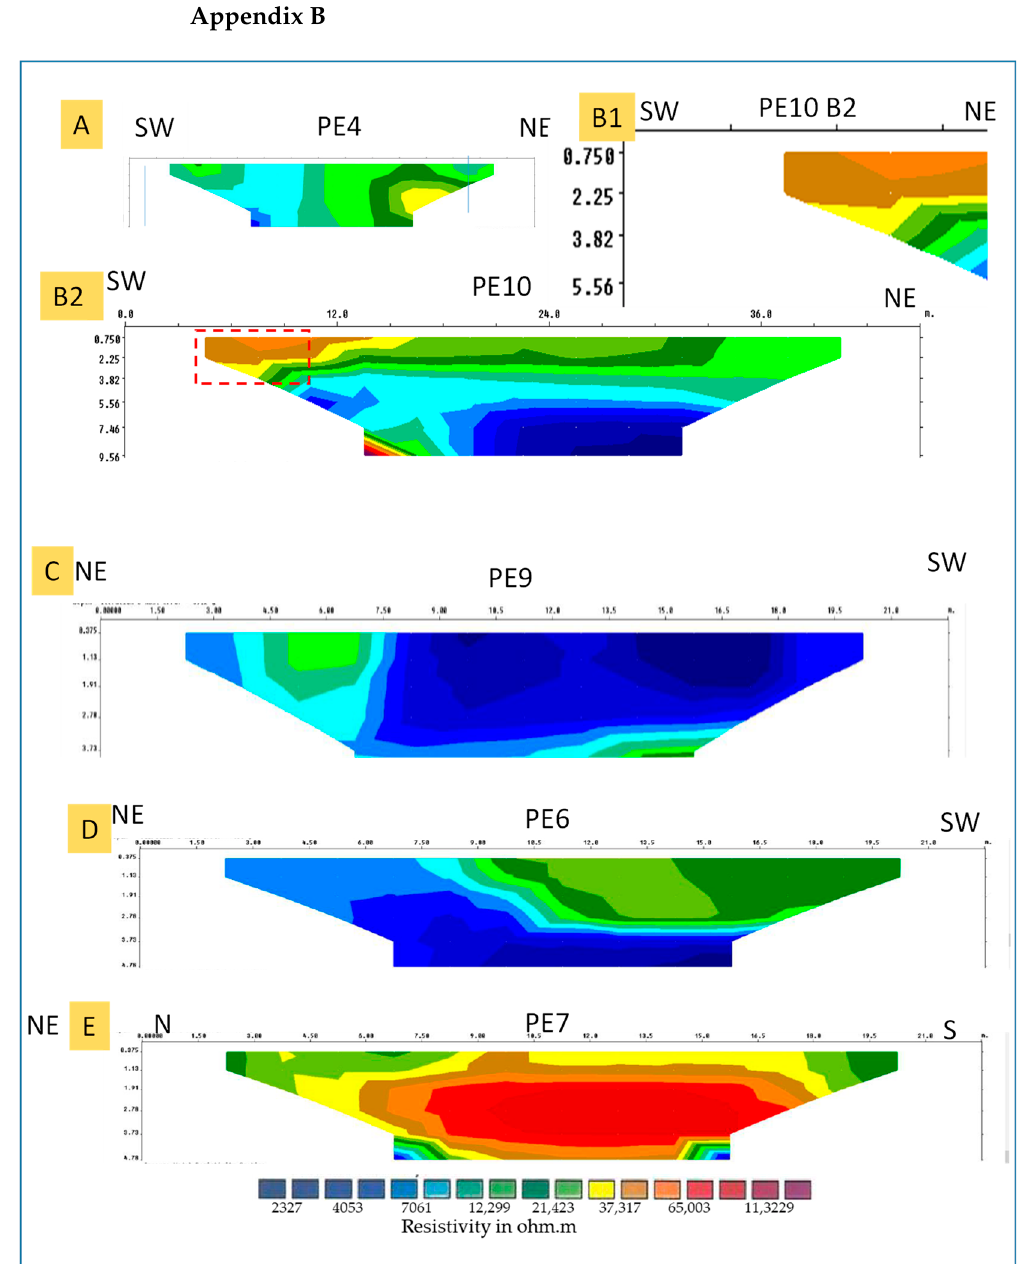
Figure A2. True electrical resistivity profiles (ERT) parallel to the mountain slopes. ( A ) Profile PE4, ( B1 ) PE10 region, which corresponds to the magnified image of the SW part of PE10 at the same scale as profile PE4 for easy comparison and interpretation; ( B2 ) Profile PE10; ( C ) Profile PE9; ( D ) Profile PE6; ( E ) Profile PE7. For the location, look at Figure 3.